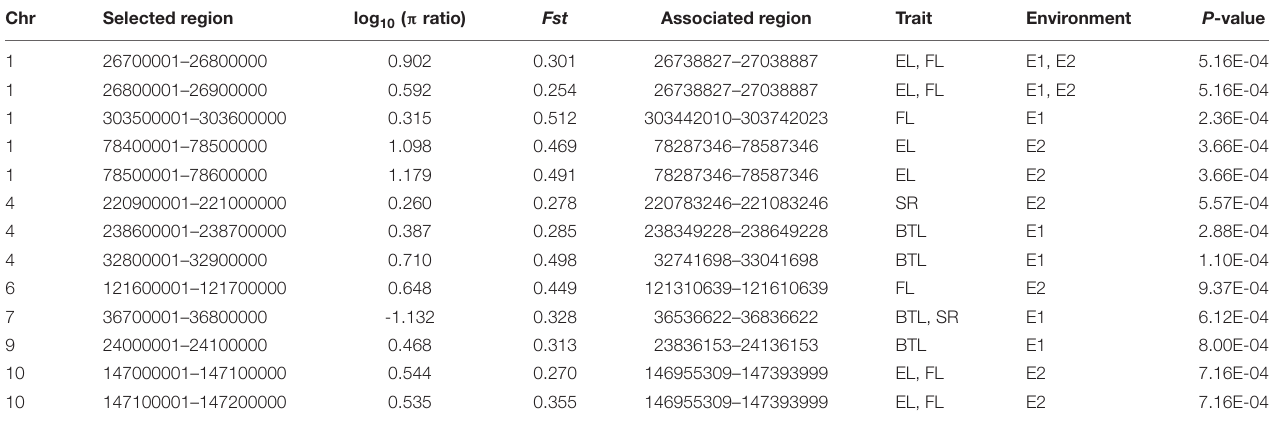
TABLE 2 | Co-localized regions detected by combining selective sweeps and GWAS.